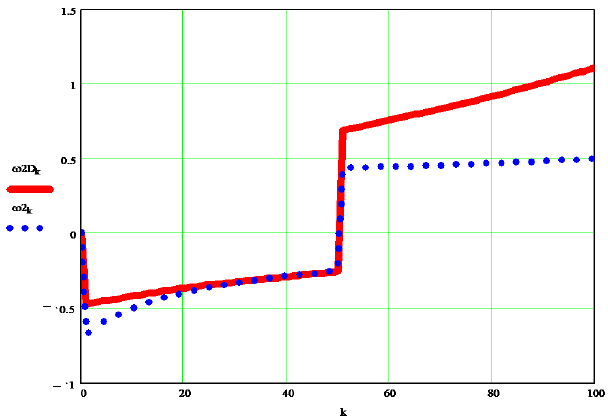
Figure 8. Difference between the kinematic speed and the classical dynamic speedof the mobile element 2 of the robot.